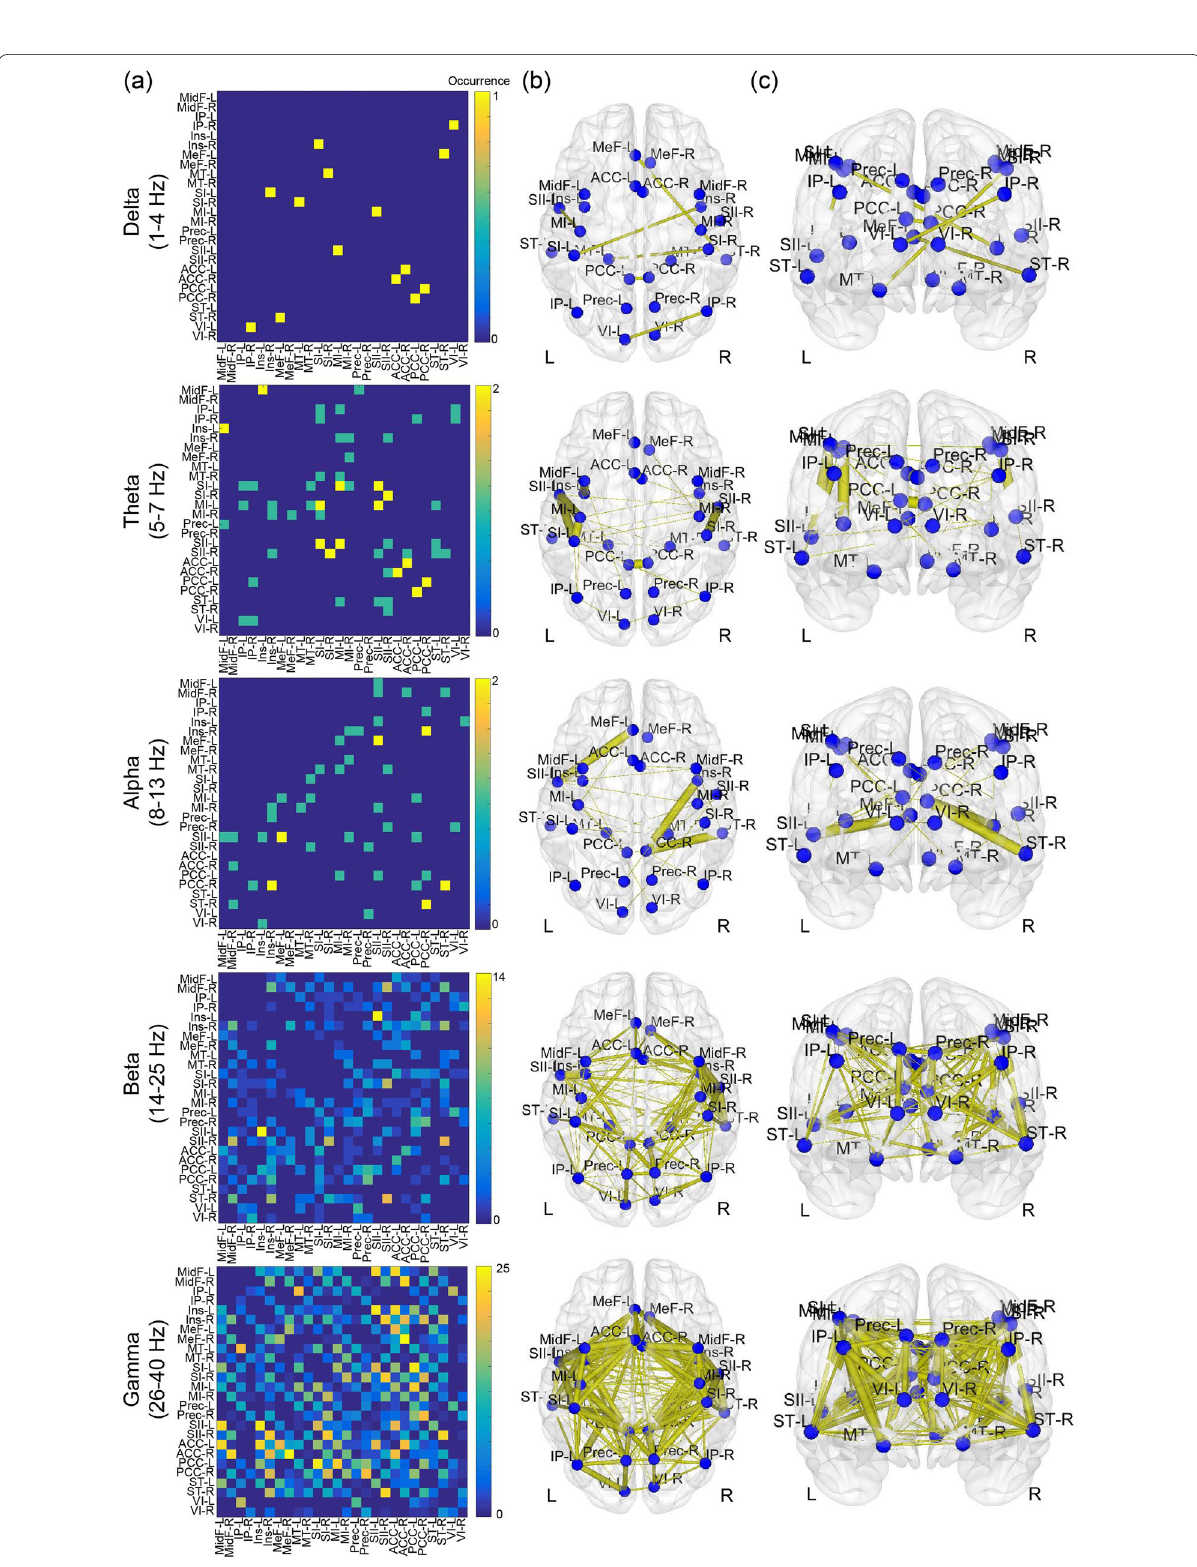
Fig. 2 Characteristic features of oscillatory connectivity for differentiating chronic migraine from healthy controls. L, left; R,